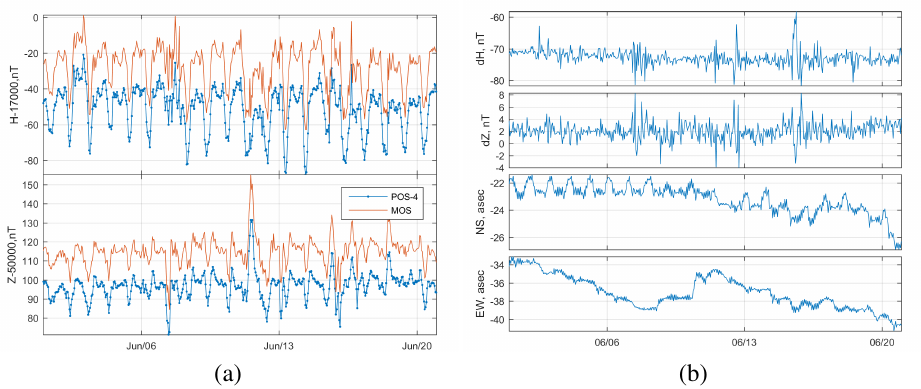
Figure 13. Hourly mean data recorded by the POS-4 and by the Observatory Moscow variometer (a) and its di ff erences and tilts of the POS-4 solenoid